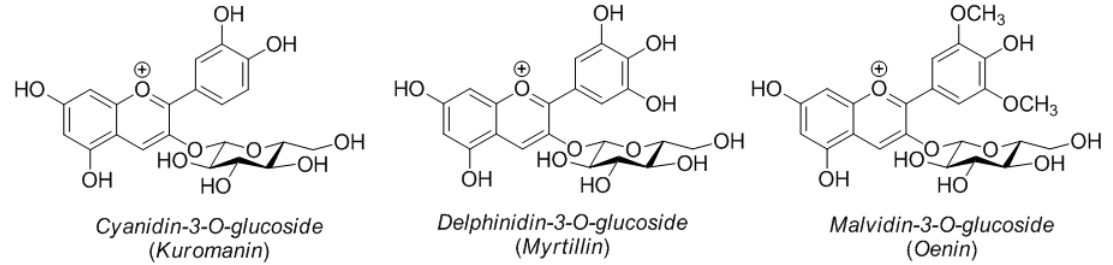
Figure 2. Chemical structures of the main anthocyanins identified by HPTLC-MS method.